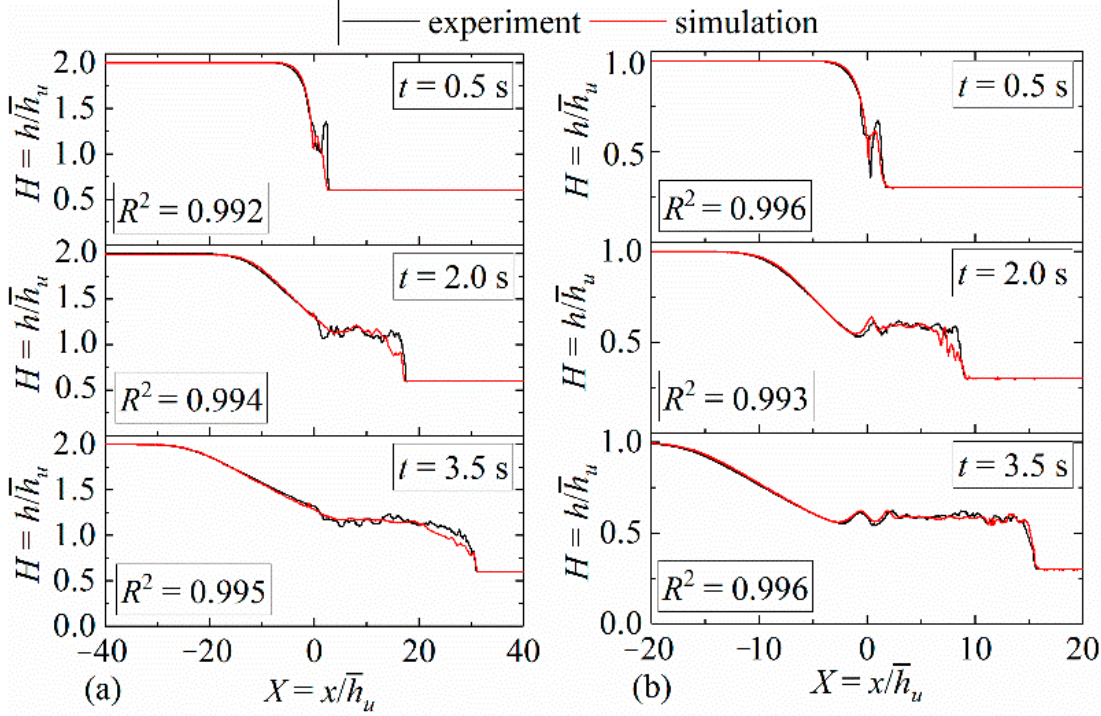
Figure 4. Comparison between simulated water surface profiles and measurements in: ( a ) A triangular channel; ( b ) a rectangular channel.